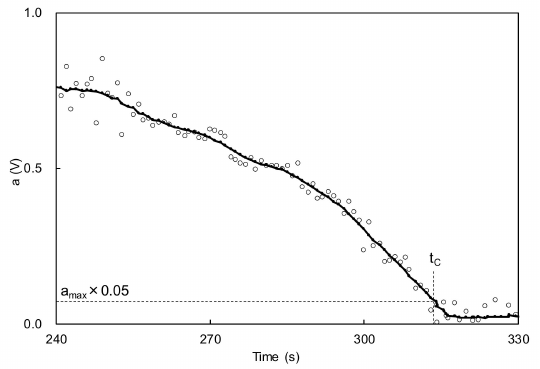
Figure 5. Example of time dependence of fluctuation width a and determination of a max .